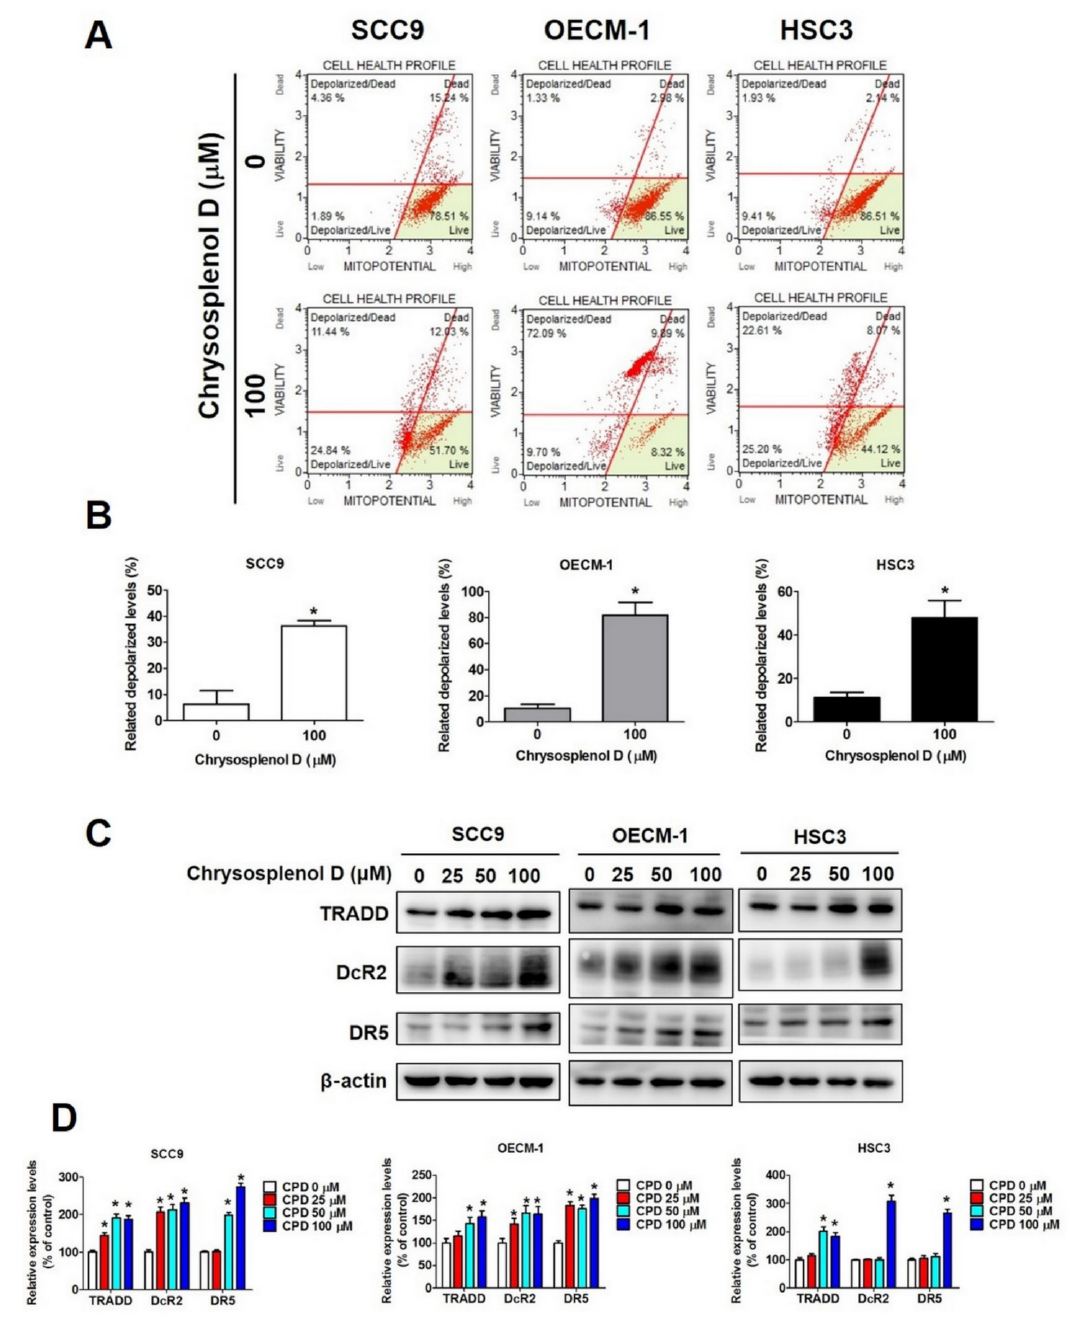
Figure 4. Chrysosplenol D regulated the mitochondrial membrane potential and death pathway in OSCC cell lines . ( A , B ) After chrysosplenol D (100 µ M) treatment for 24 h, OSCC cells were collected and measured using a Muse cell analyzer. Quantitative data were analyzed using Muse cell software V1.4.0.0. ( C , D ) The expression level of death receptor proteins, namely TRADD, DcR2, and DR5, was measured through Western blot analysis. The β -actin protein level was used to adjust quantitative results. Data are presented as the mean ± SD from three independent experiments * p < 0.05 compared with the vehicle treatment